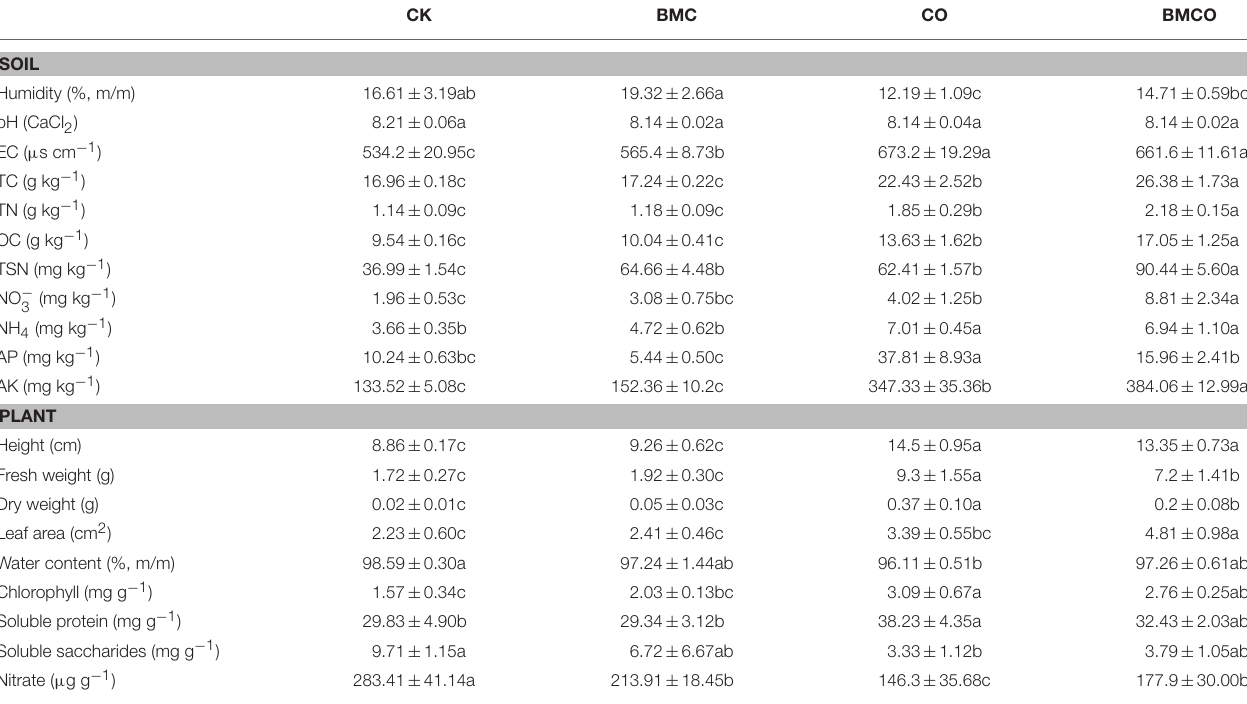
TABLE 3 | Average edaphic and plant parameters (mean ± s.e .; n = 5) for each